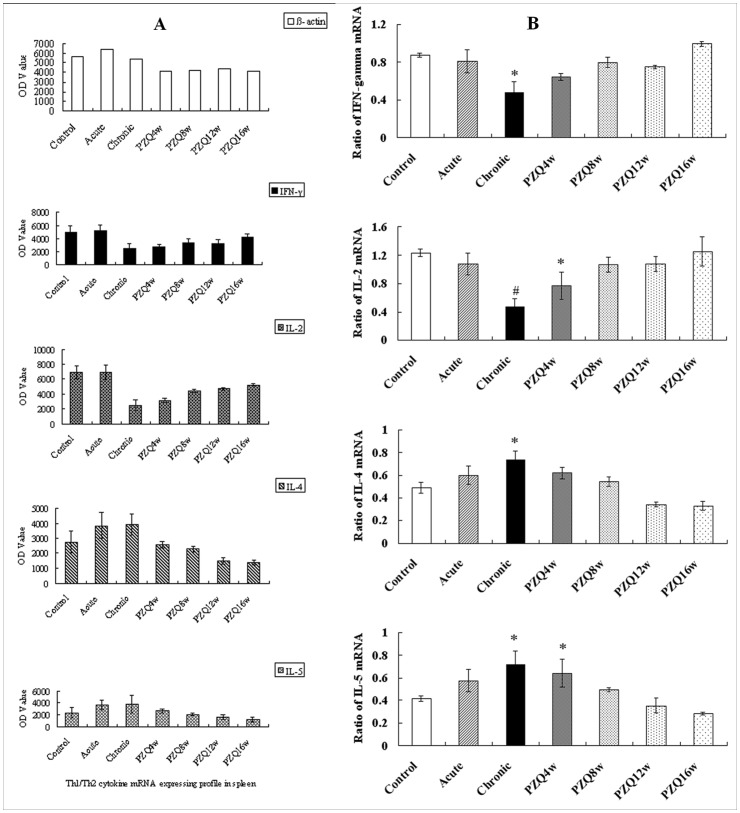
Levels of Th1/Th2 cytokine mRNA RT-PCR production of mice spleens.The PCR amplified fragments were analyzed on agarose gel. The optical density of each band was measured with a computer-assisted image analysis system. Relative expressions of Th1/Th2 cytokine mRNA were analyzed by the ratio of the band density of its amplified fragment over that of β-actin. A: OD values of RT-PCR products from Th1/Th2 cytokine mRNA and β-actin. B: The ratios of Th1/Th2 cytokine mRNA expression. The data in Fig. 4B does not necessarily reflect the exact ratios of each cytokine mRNA to b-actin, because PCR amplification is not exponential at high cycle numbers. *P<0.05 versus control group, # P<0.01 versus control group.